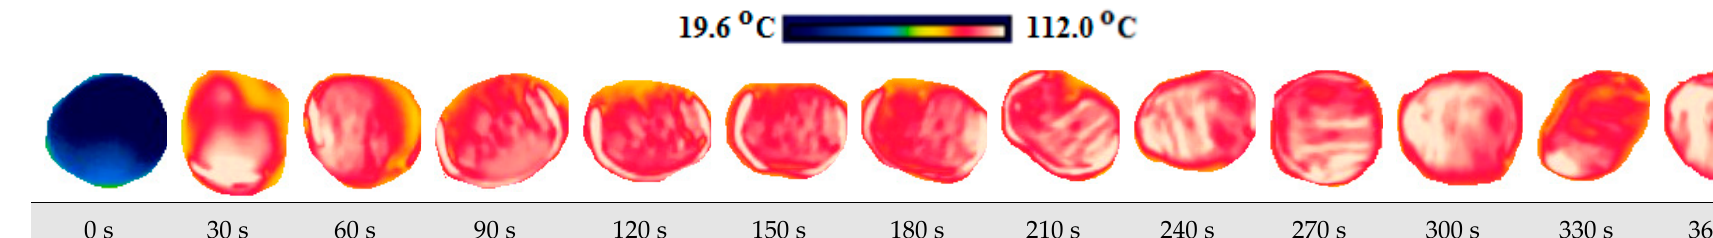
Figure 19. Thermal images of persimmon with 9 mm at 350 W.